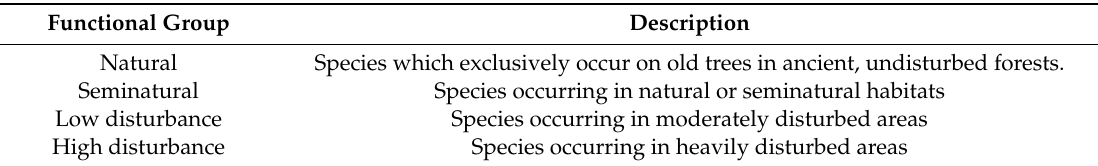
Table 1. Description of each of the four functional groups of the poleotolerance response trait. Description follows as in Nimis